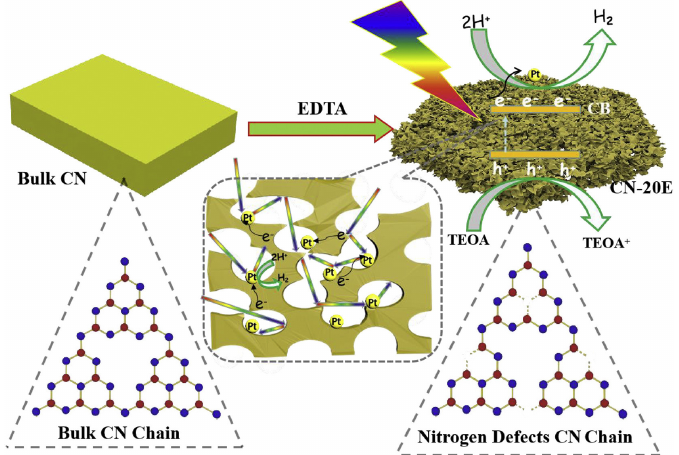
Figure 18. Scheme of the morphology superiority for the photocatalytic H 2 production for defective hexagon of g-C 3 N 4 under vis irradiation. Copyrights 2020 Elsevier [146].